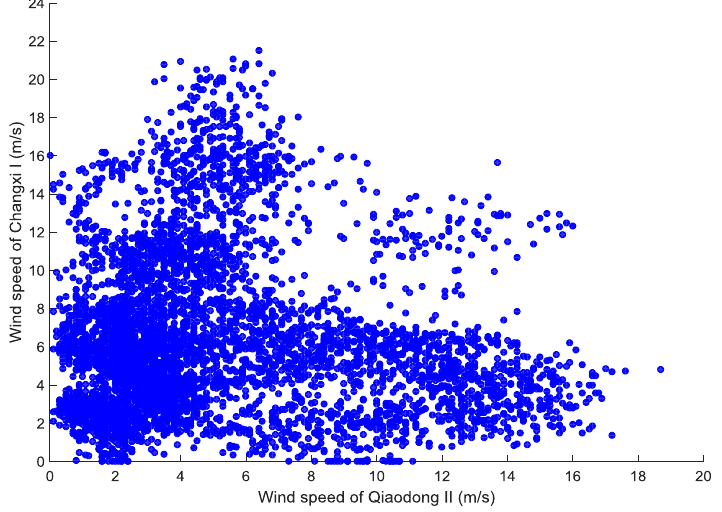
Figure 12. Scatter diagram of wind speeds of the Qiaodong II and Changxi I wind farms.